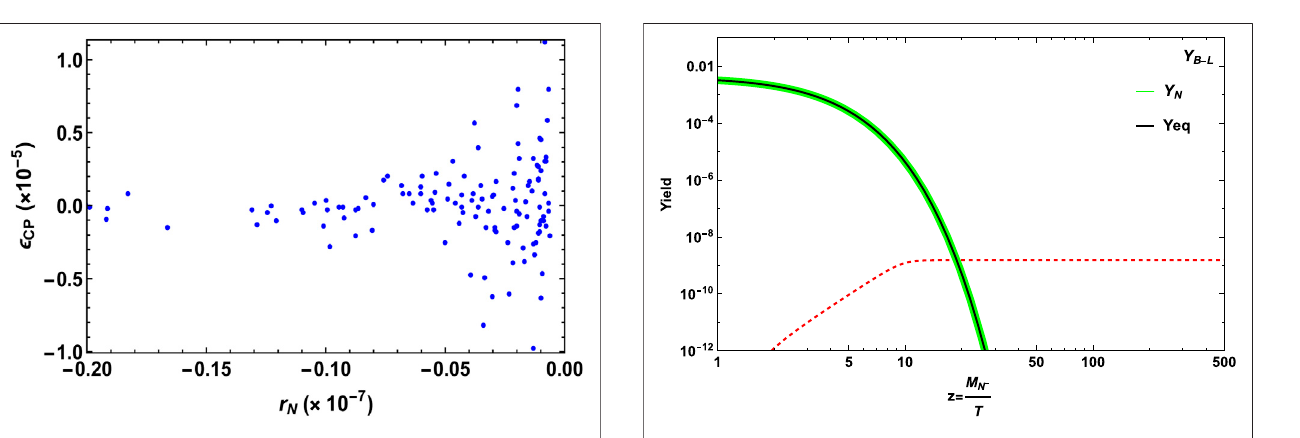
FIGURE 5 | Evolution of the yield parameters Y N and Y L as a function of z (cid:2) M N − / T